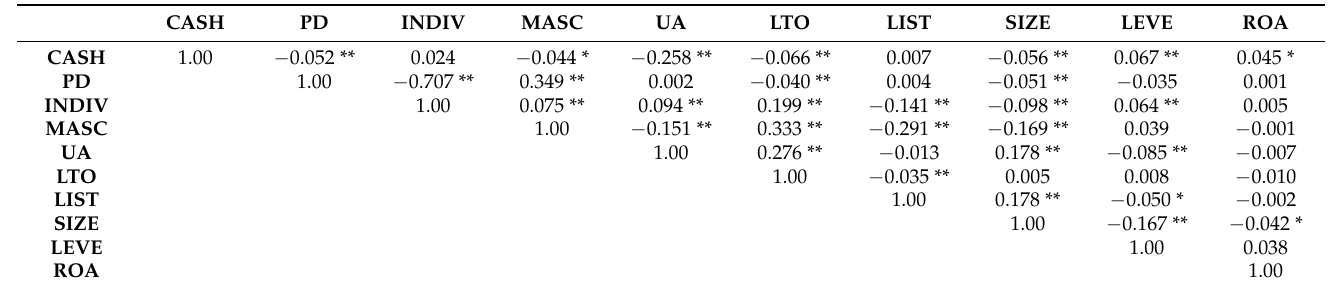
Table 3. Correlation